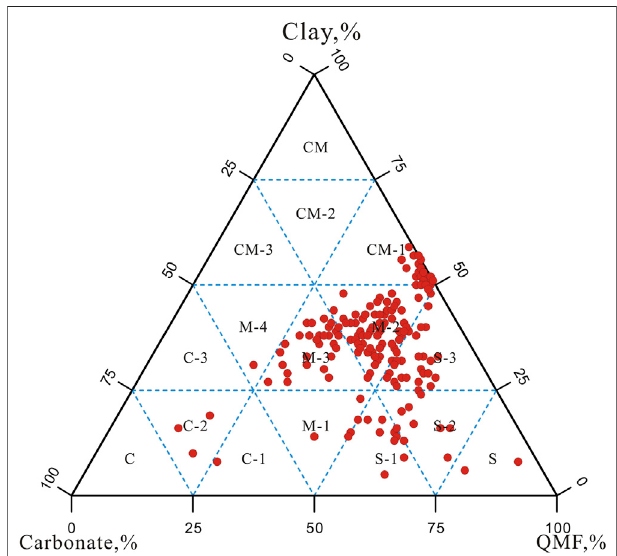
FIGURE 3 | Ternary lithofacies diagram of the Wufeng – Longmaxi FormationintheL203wellareaSESichuanBasin.CM,mudstonefacies;CM- 1, silicon-rich argillaceous shale facies; CM-2,mixedargillaceousshale facies; andCM-3,calcium-richargillaceousshalefacies;S,siliceousfacies;S-1, calcium-rich argillaceous shale facies; S-2, mixed siliceous shale facies; and S-3, mud-rich siliceous shale facies; C, limestone facies; C-1, silica-rich calcareous shale facies; C-2, mixed calcareous shale facies; and C-3, mud- richcalcareousshalefacies;andM-1,calcareous/silica-mixedshalefacies;M- 2, silica/mud-mixed shale facies; M-3, calcareous/mud-mixed shale facies; and M-4, mixed shale.